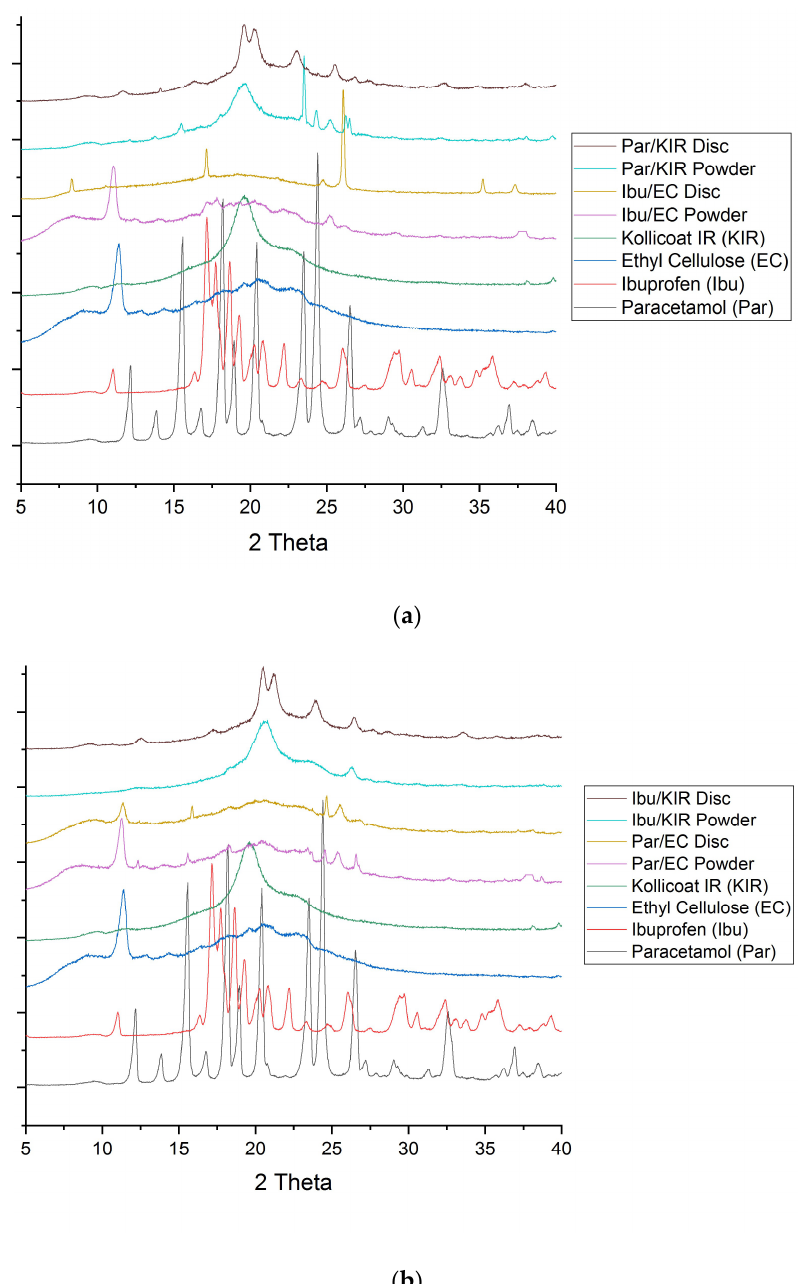
Figure 4. X-ray diffractograms of the drugs-excipients prior to printing and the 3D printed discs used in ( a ) Con A and ( b ) Con B of the dual miniprintlets.